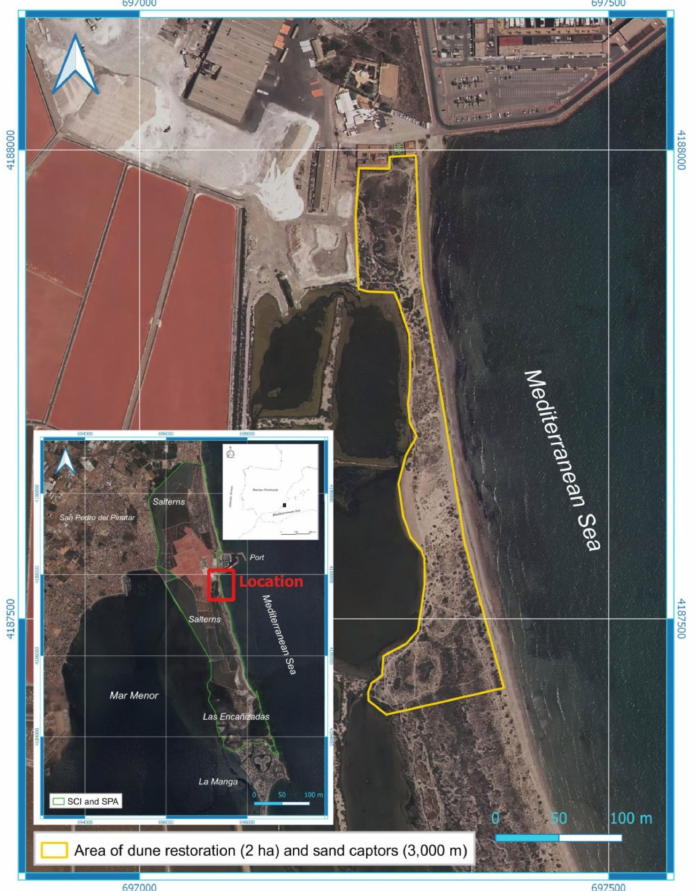
Figure 2. Stabilization and reinforcement of the dunes of the Llana beach (Source: own